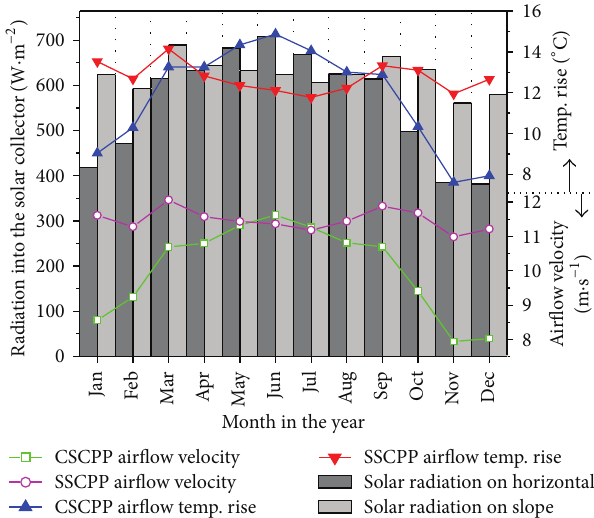
Figure 5: Monthly average energy input, temperature, and updraft flow velocities of the CSCPP and SSCPP.